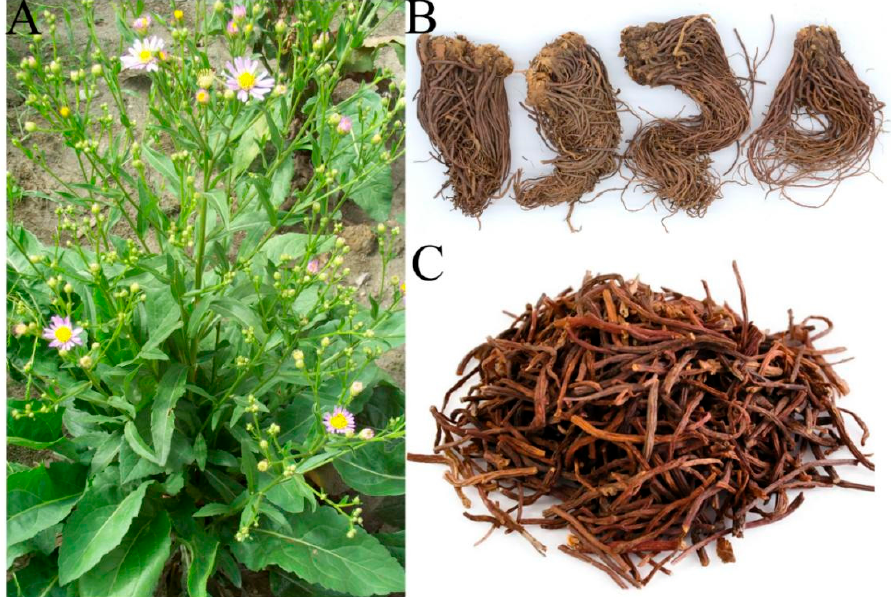
Figure 1. The aerial parts ( A ), roots ( B ), and TCM decoction pieces ( C ) of Radix Asteris.